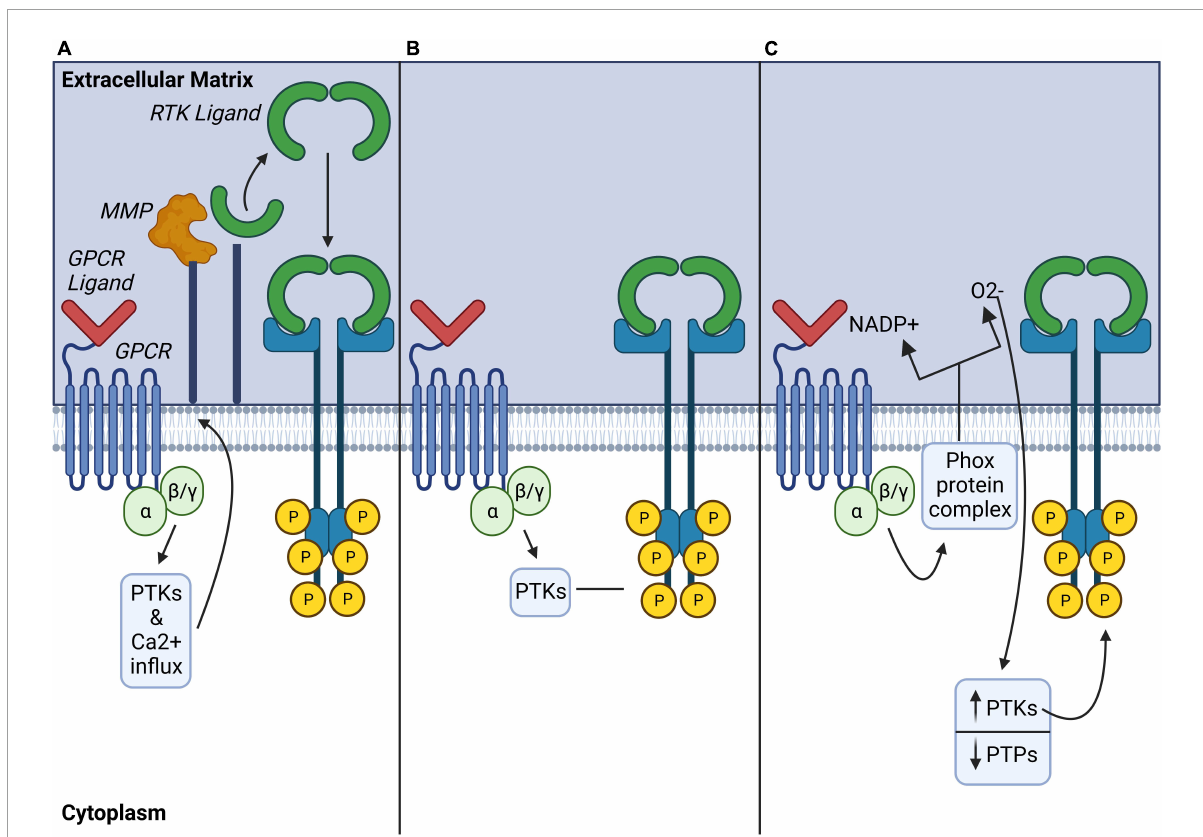
FIGURE3 Ligand-dependent, ligand-independent, and atypical mechanisms of GPCR modulation of RTKs. (A) Ligand-dependent transactivation: Activated GPCRs induce a variety of downstream signaling pathways including activation of phospho-tyrosine kinases (PTKs), or increase of the influx of Ca 2 + , which activates matrix metalloproteinases (MMP) to cleave cell membrane-bound RTK ligands. (B) Ligand-independent transactivation: Activated GPCRs may also recruit intracellular PTKs to directly phosphorylate tyrosine residues on the intracellular domain of RTKs and induce their activation in a ligand-independent manner. (C) Atypical transactivation: Phox protein complexes activated by GPCRs generate reactive oxygen species which modulate phospho-tyrosine kinases (PTK) and phosphotyrosine phosphatases (PTP) activity to promote phosphorylation of intracellular RTK tyrosine residues. GPCR, G protein coupled receptor; MMP, matrix metalloproteinase; PTK, phosphotyrosine-kinase; PTP, phosphotyrosine